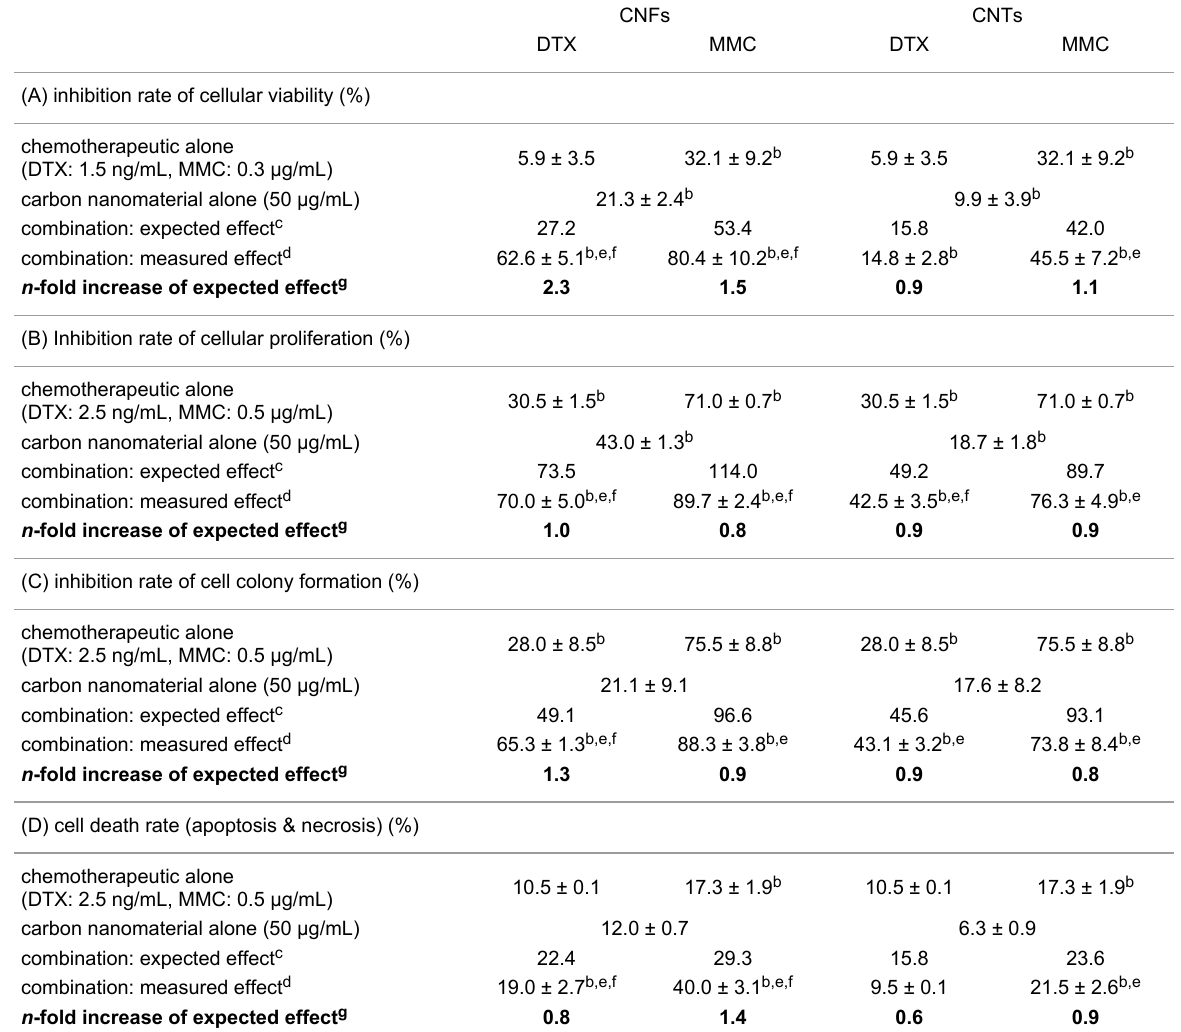
Table 1: Effect on (A) cellular viability, (B) cellular proliferation, (C) cell colony formation and (D) cell death rate of DU-145 cells following treatment with carbon nanomaterials and chemotherapeutics alone or in combination. a CNFs CNTs DTX MMC DTX